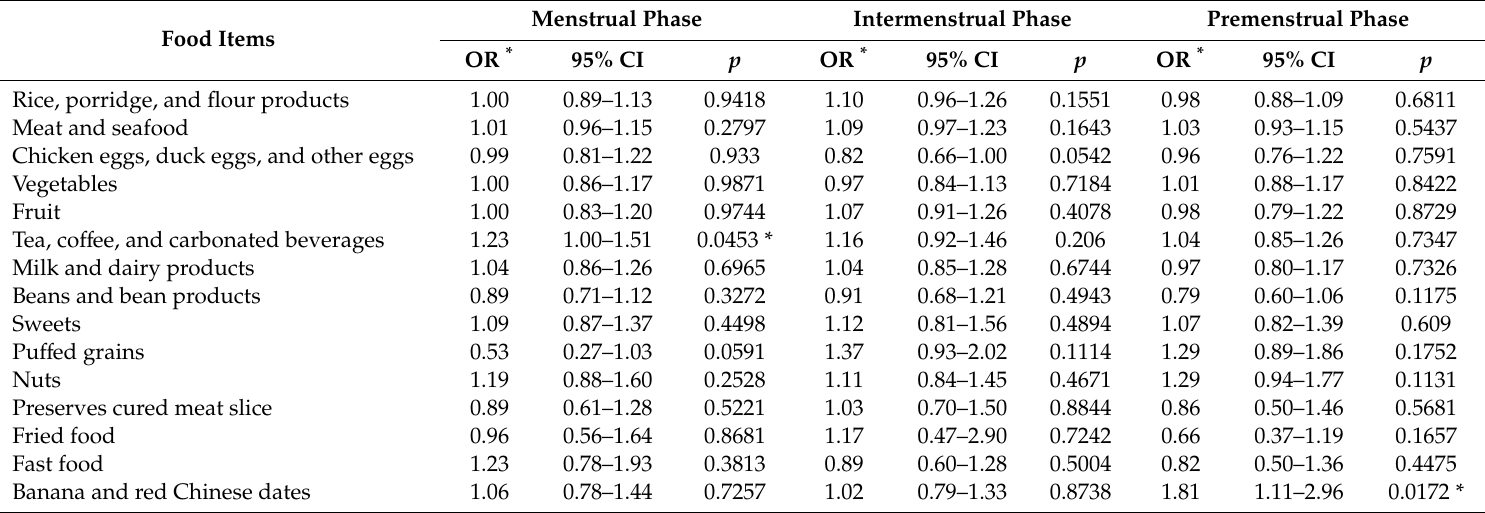
Table 3. Logistic regression analysis between negative a ff ect and food consumption